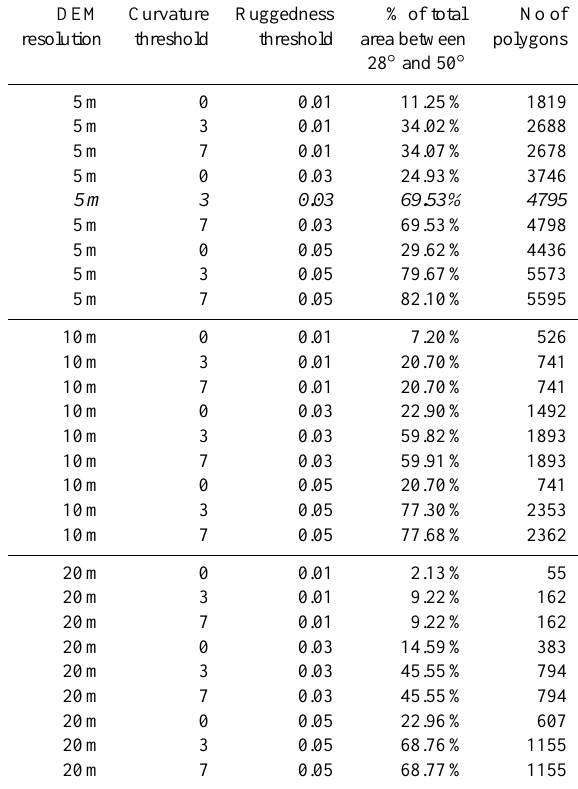
Table 1. Calculated parameter settings to find the optimal trade-off of mapping only as much area as necessary without missing many avalanche release zones for the test site Davos. The selected param- eter set is marked in